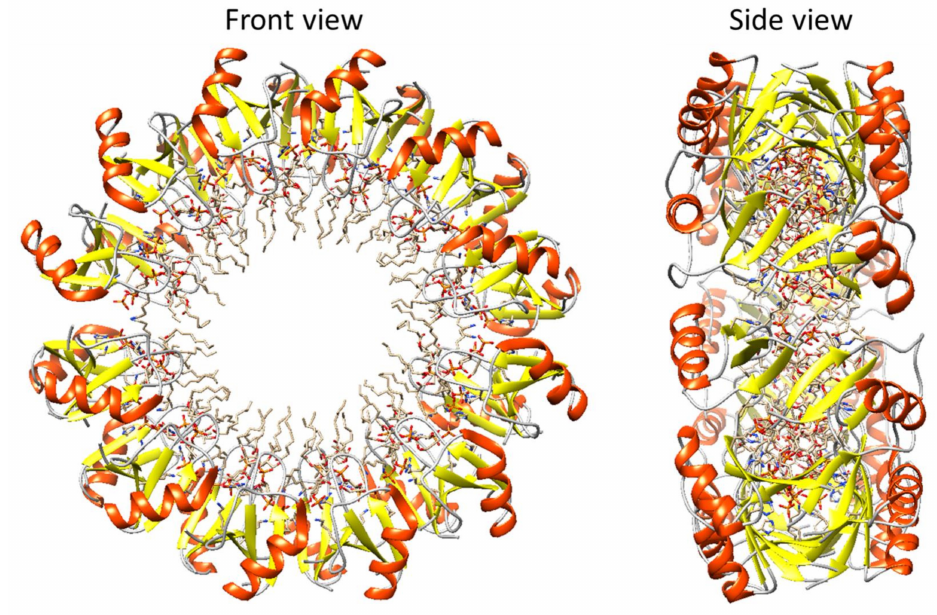
Figure 5. Constructed oligomeric structure of plant antimicrobial peptide defensin NaD1 containing 24 NaD1-PIP2 units. Packing of oligomers was completed by the YASARA program [100]. Peptides from some plant antifungal defensins can form amyloid fibrils. It was shown that the NaD1-19 peptide does not form amyloid fibrils compared to the RsAFP-19 peptide (19 amino acid fragment from the C-terminal region of Raphanus sativus antifungal protein). Thus, the ability to form amyloids is not a general property of peptides from plant defensins that have antifungal features